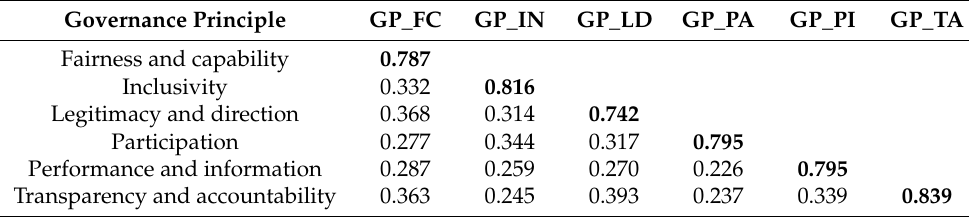
Table 8. Model discriminant validity: Fornell–Lacker